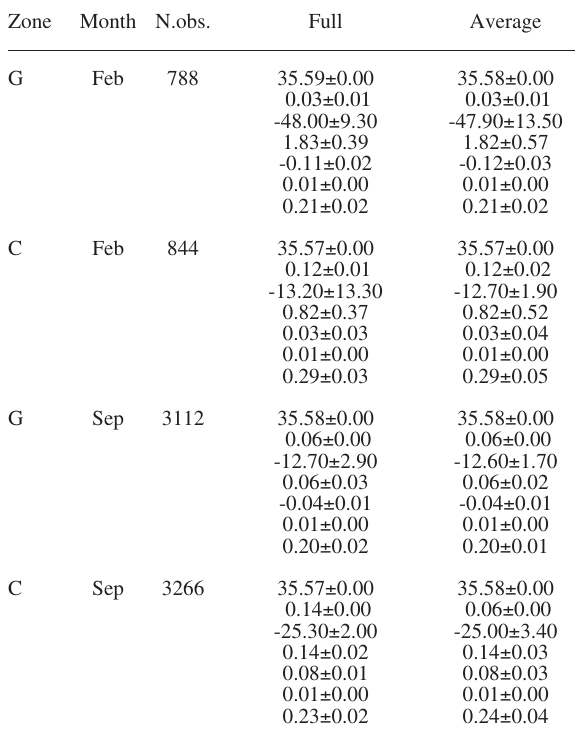
Table 2. – Coefficients estimated with the whole data set and aver- aging from subsets within the Galician Area (G) and Cantabrian Sea (C). Months and number of available observations are indicated. Coefficients considered are a , a , a , a , b , b and b . Note that the 0 1 2 3 1 2 3 third coefficient is multiplied by 10 3 , the fourth by 10 2 , the fifth by 10 3 , the sixth by 10 4 and the seventh by 10 8